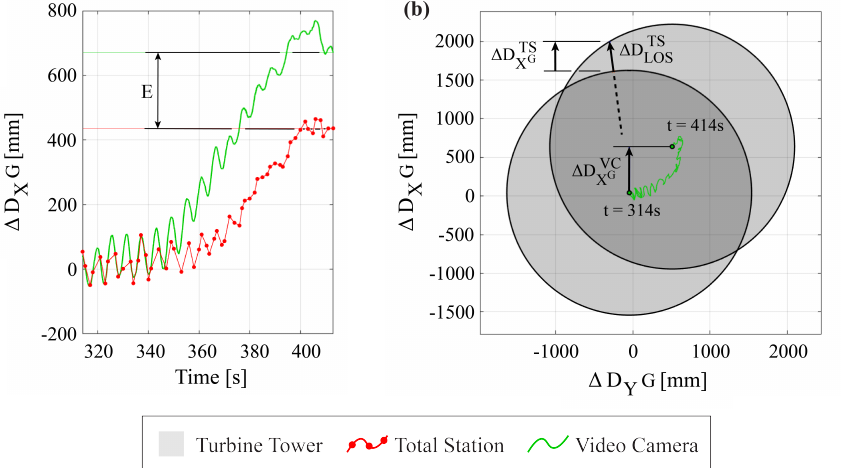
Figure 9. Deformation ∆ D of the wind turbine tower at heights of ( a ) 120, ( b ) 38, and ( c ) 9m X G above the ground.